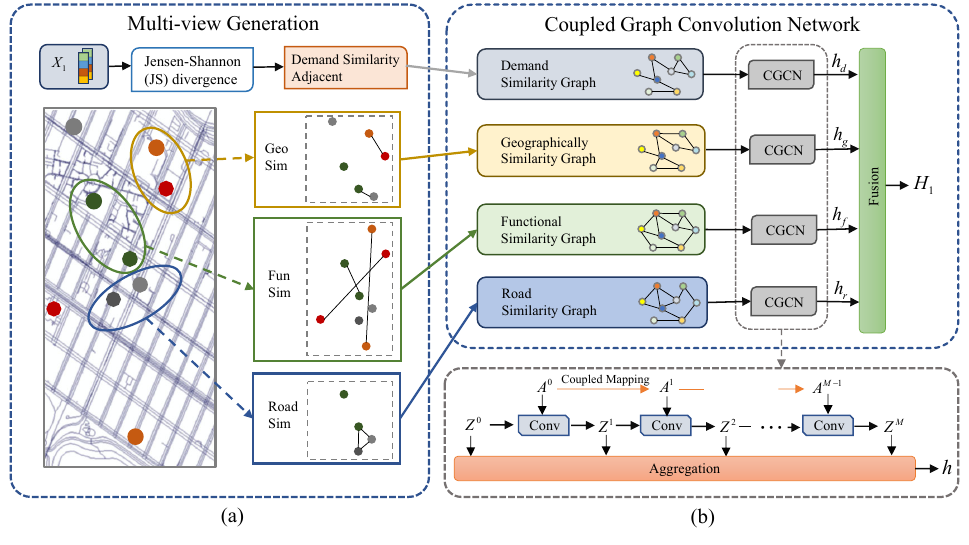
Figure 4. Multi-view coupled graph convolutional